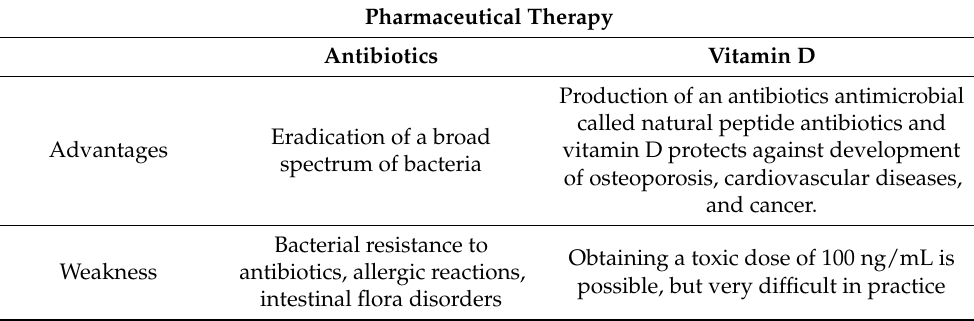
Table 3. Pharmaceutical support for